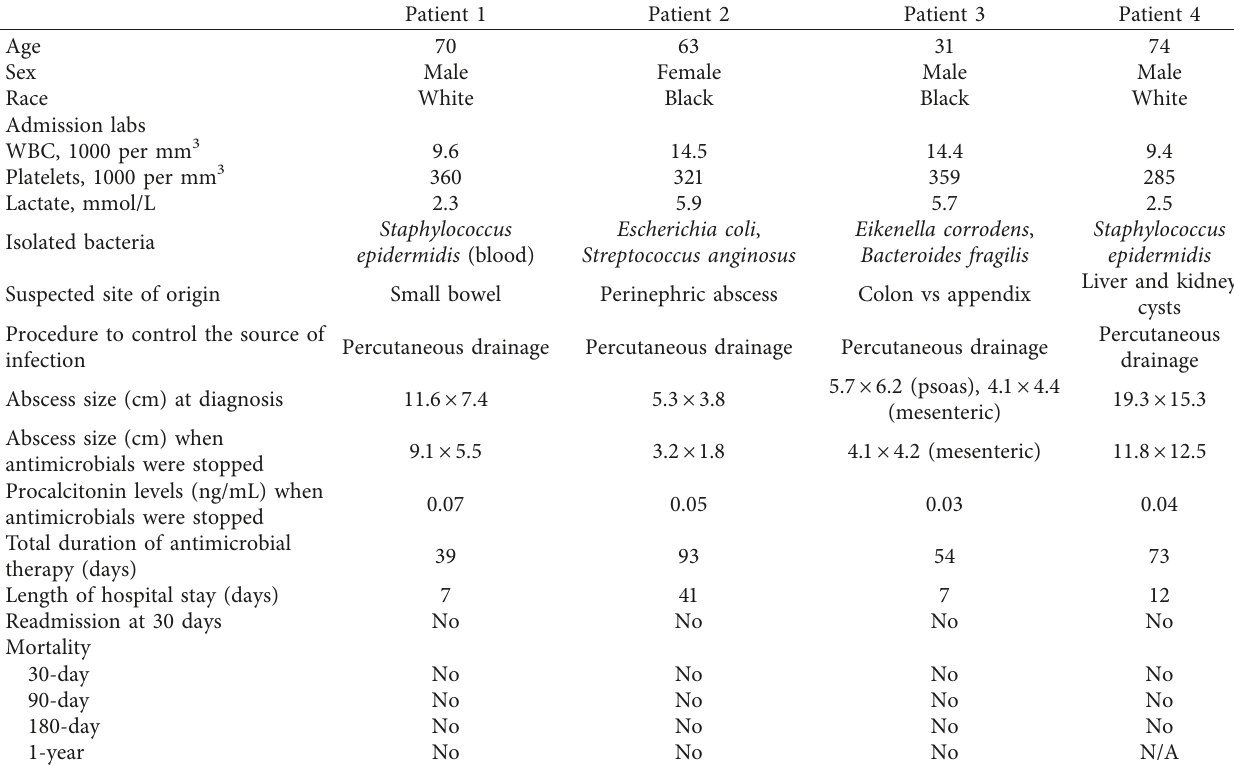
Table 1: Demographic characteristics, clinical manifestations, and outcomes of patients with intra-abdominal